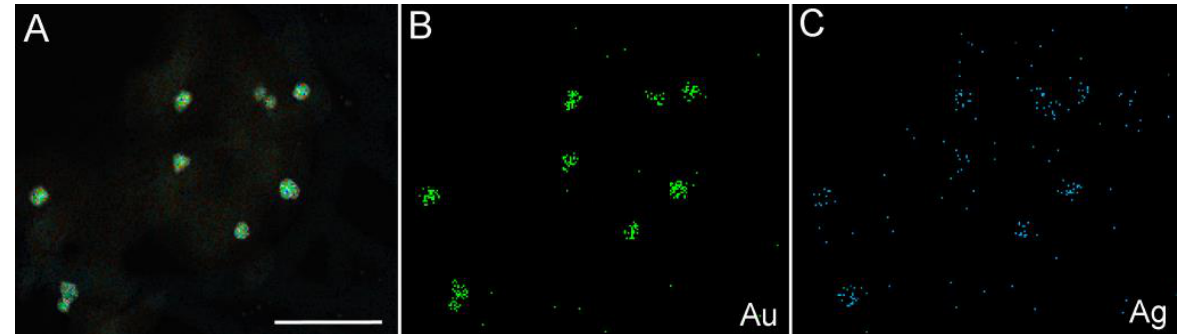
Figure 3. HAADF-STEM image of AuAg-g-C 3 N 4 nanohybrid 3 displaying 10 nm size metal nanoparticles. EDS elemental mapping images for elements Au and Ag: image ( A ) displays both elements mapping at a time, while images ( B , C ) display the individual Au and Ag elemental maps, respectively (bar corresponds to 100 nm).